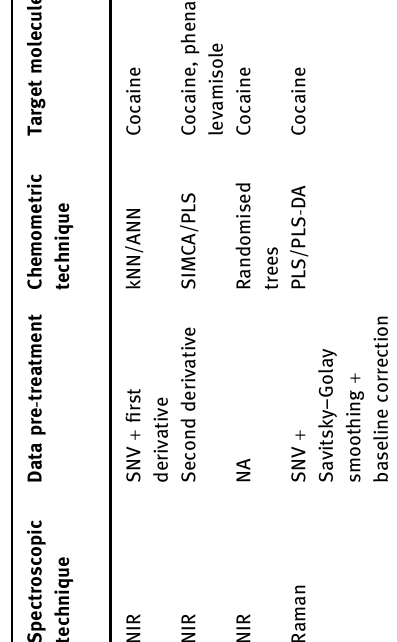
models with 100% correct classi fi cation rates using PLS - DA and SVM - DA, respectively, to di ff erentiate between salt and